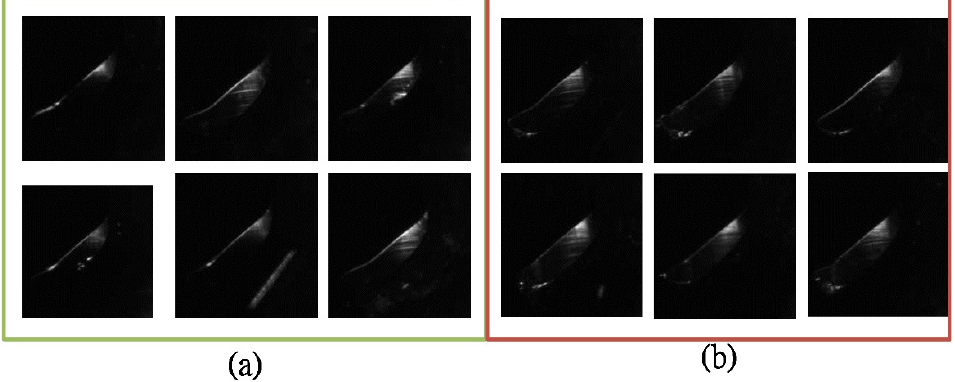
Figure 6. ( a ) Examples of six OK images and ( b ) six NG images.